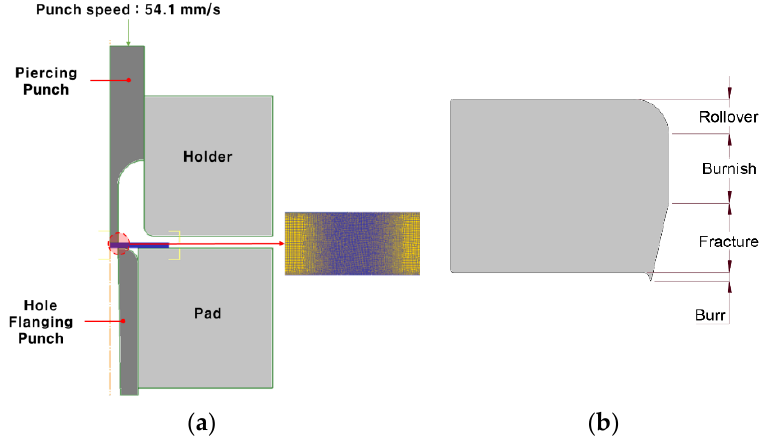
Figure 3. ( a ) Finite element modeling of the piercing process and analysis conditions; ( b ) measure- ment of shear plane distribution.